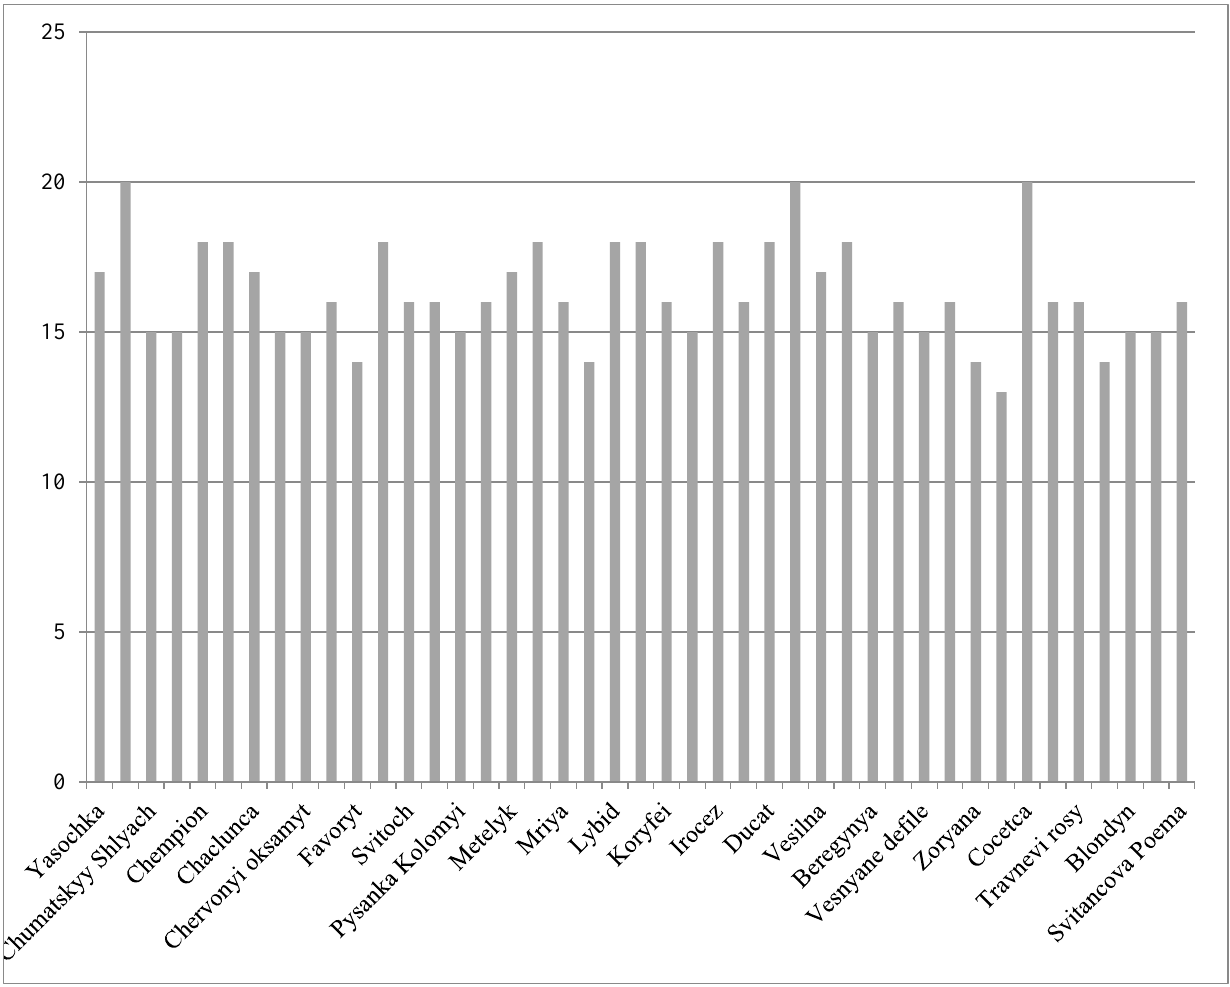
Fig. 3. Flower diameter of the peonies, entered into the state registry of Ukraine, cm Growth, like all other processes in a plant, is a function of time, which is outwardly expressed in periodic and rhythmic fluctuations of its intensity and can be expressed by a mathematically positive magnitude.